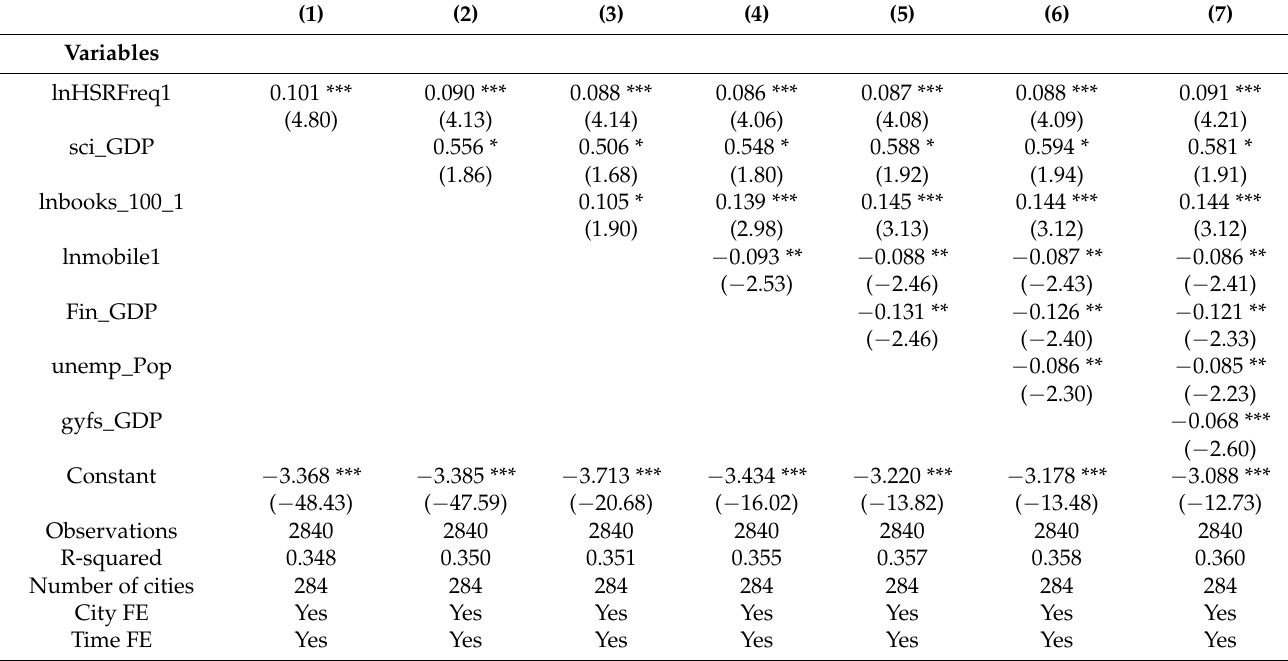
Table 3. The empirical results of the baseline